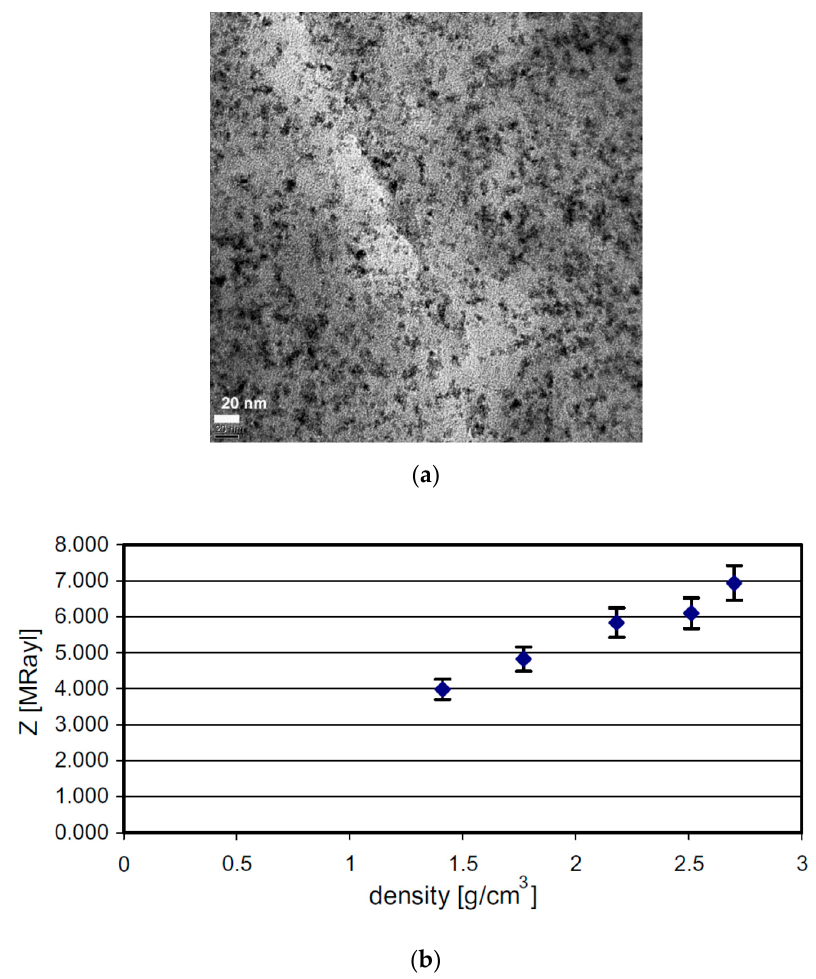
Figure 10. ( a ) A TEM picture of the epoxy matrix embedded with cerium oxide particles (10 wt